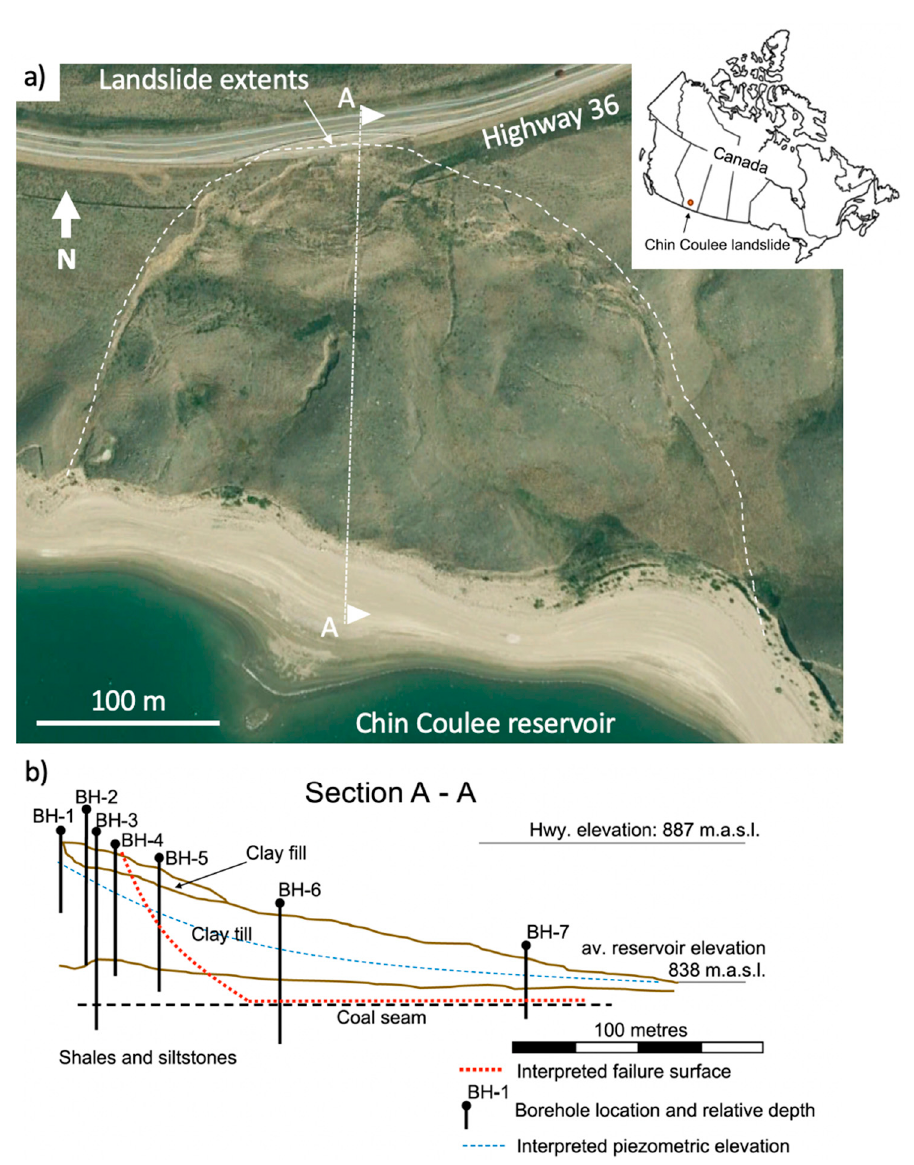
Figure 2. Location, aerial view ( a ) and typical geologic cross section ( b ) of the Chin Coulee landslide. Adapted from